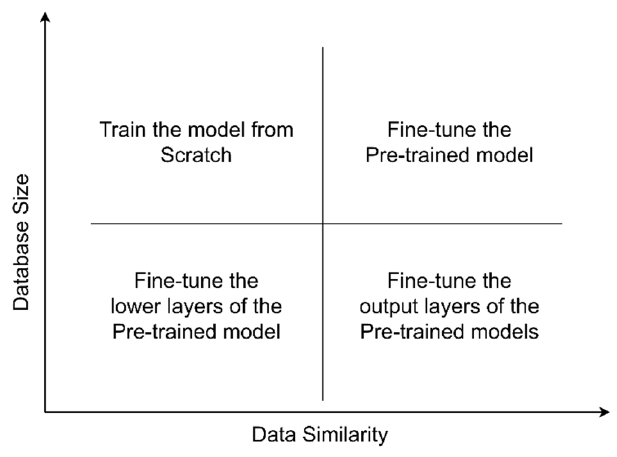
Figure 4. Approaches in transfer learning.